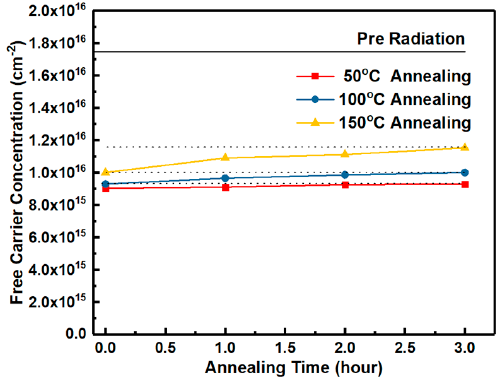
Figure 17. The extracted free carrier concentration of the epilayer at different stages of the isochronal annealing.